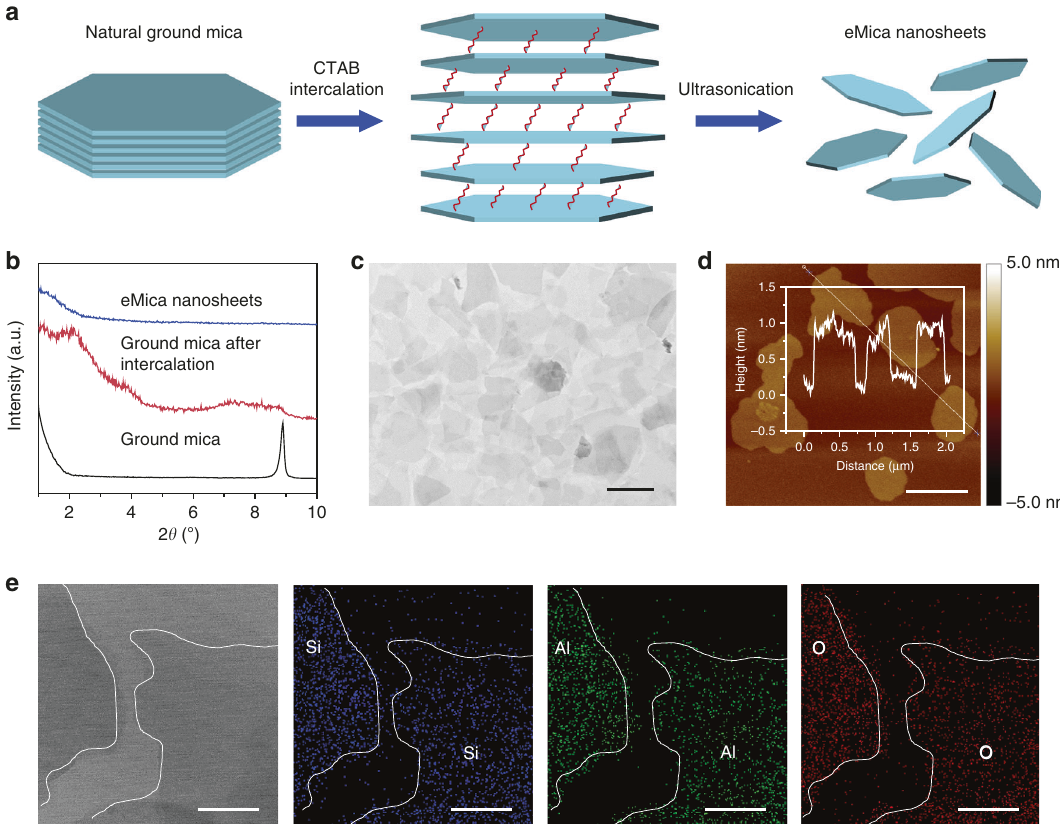
Fig. 1 Characterization of eMica nanosheets. a Schematic illustration showing the exfoliation process of natural ground mica into eMica nanosheets via intercalation with CTAB followed by ultrasonication treatment. b Small-angle XRD patterns of ground mica, mica after intercalation, and eMica nanosheets. c , d TEM and AFM height images of eMica nanosheets. Scale bars, 500 nm; z scale, − 5.0 to 5.0 nm. Insert in ( d ) displays the thickness (~1 nm) of eMica nanosheets measured by AFM. e TEM image of eMica nanosheets and relative EDX elemental maps of Si, Al, and O in the eMica nanosheets. Scale